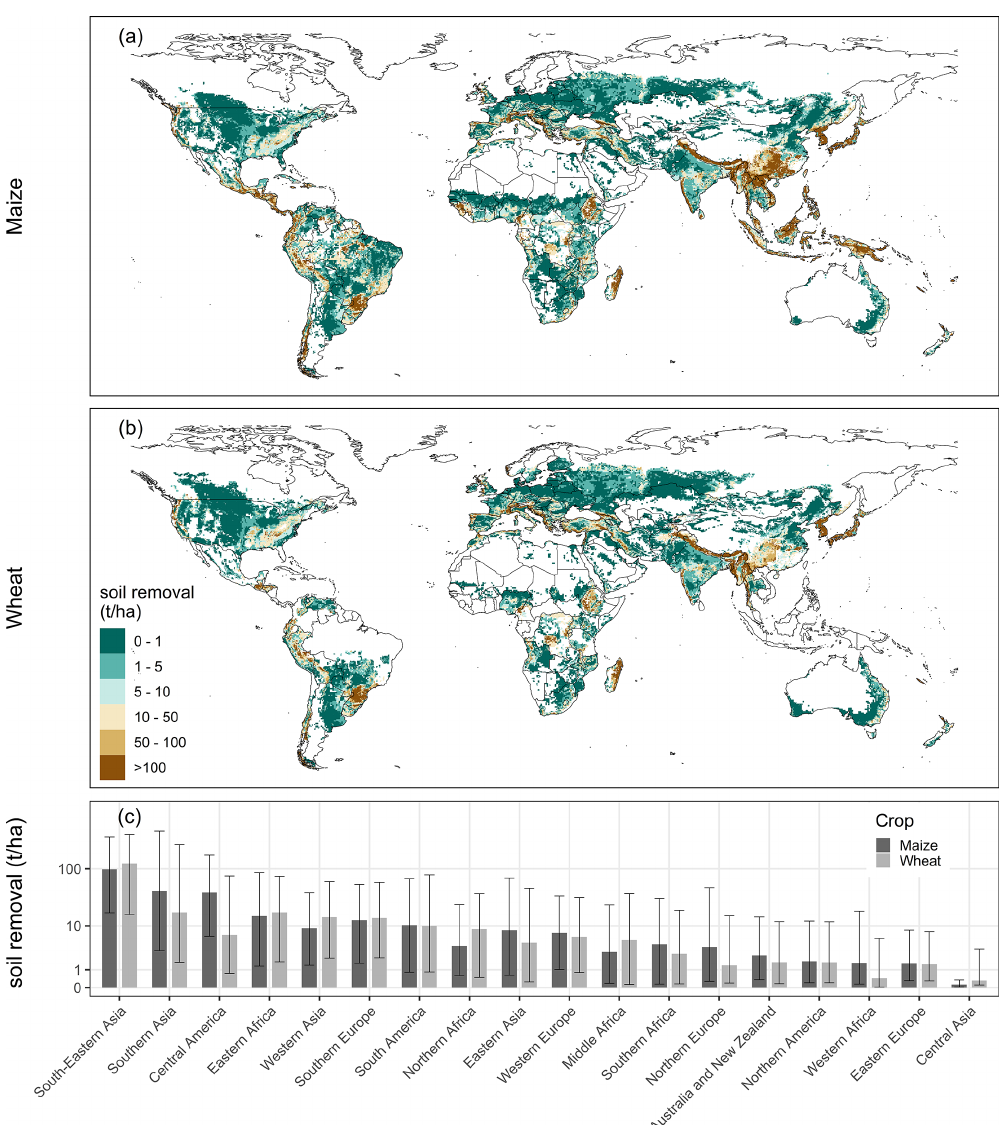
Figure 2. Soil loss due to water erosion in maize (a) and wheat (b) fields simulated with the baseline scenario. Each pixel cell illustrates the median relative water erosion of one representative field. The extent of cropland areas is not considered in pixel cell size. The bars in the bottom plot (c) illustrate median soil removal for major world regions simulated under maize and wheat cultivation. The lines and whiskers illustrate the 25th and 75th percentile values. The classification of world regions is illustrated in Fig. S3. Due to the large gap between aggregated values, all values in the bottom plot have been log-transformed to facilitate the visual